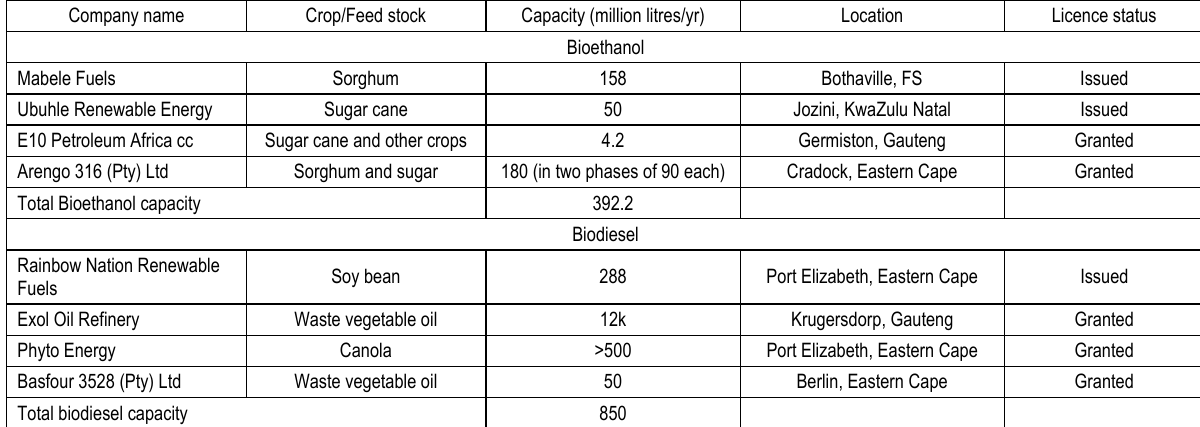
Table 1. Biofuels licence status as of